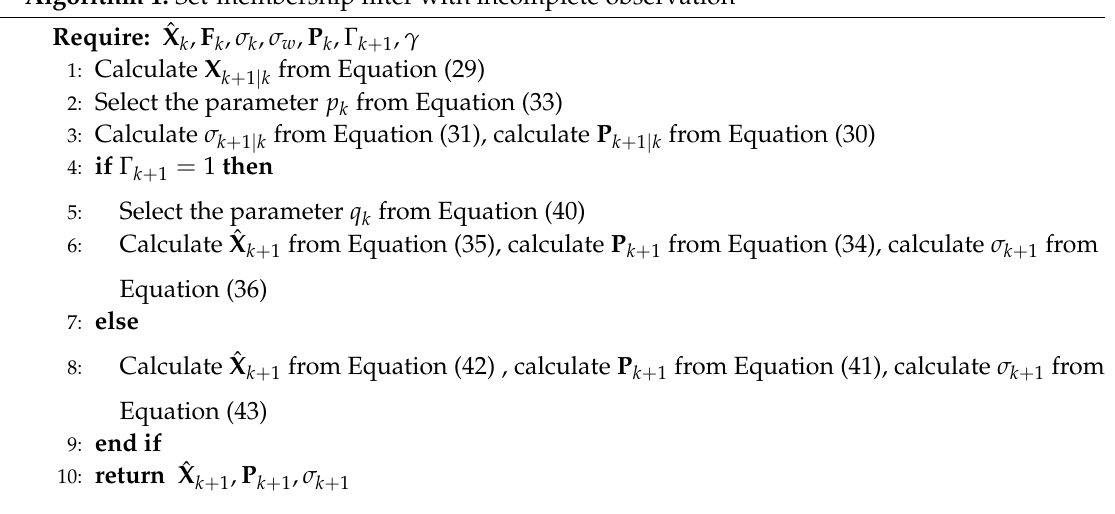
Algorithm 1: Set-membership filter with incomplete